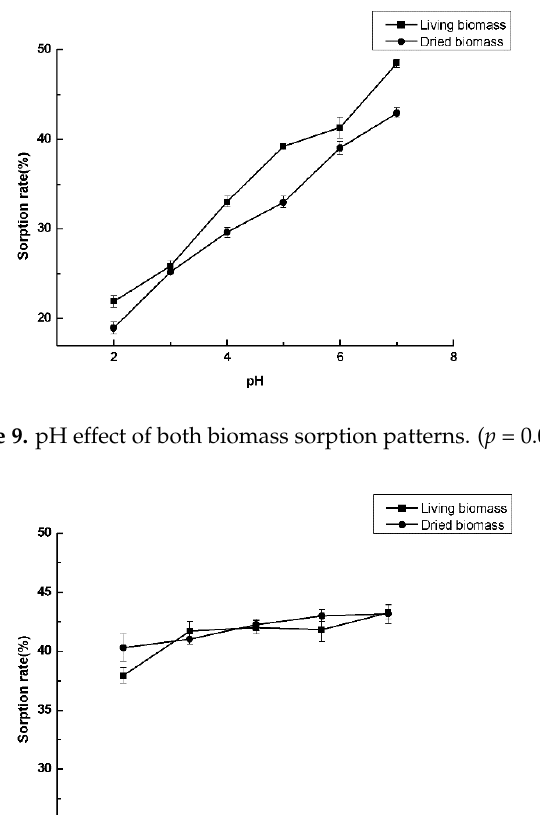
Figure 10. Temperature effect of both biomass sorption patterns. ( p = 0.048).